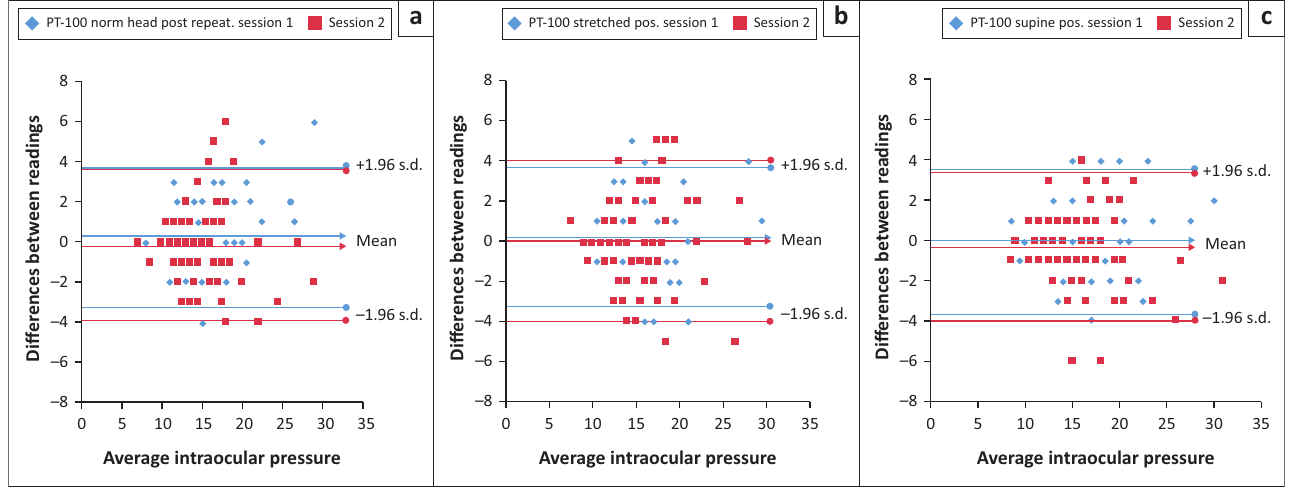
FIGURE 2: Limits of within-session repeatability for PT-100 non-contact tonometer, measurements in mmHg: (a) head-body posture 1, (b) head-body posture 2 and (c) head-body posture 3.